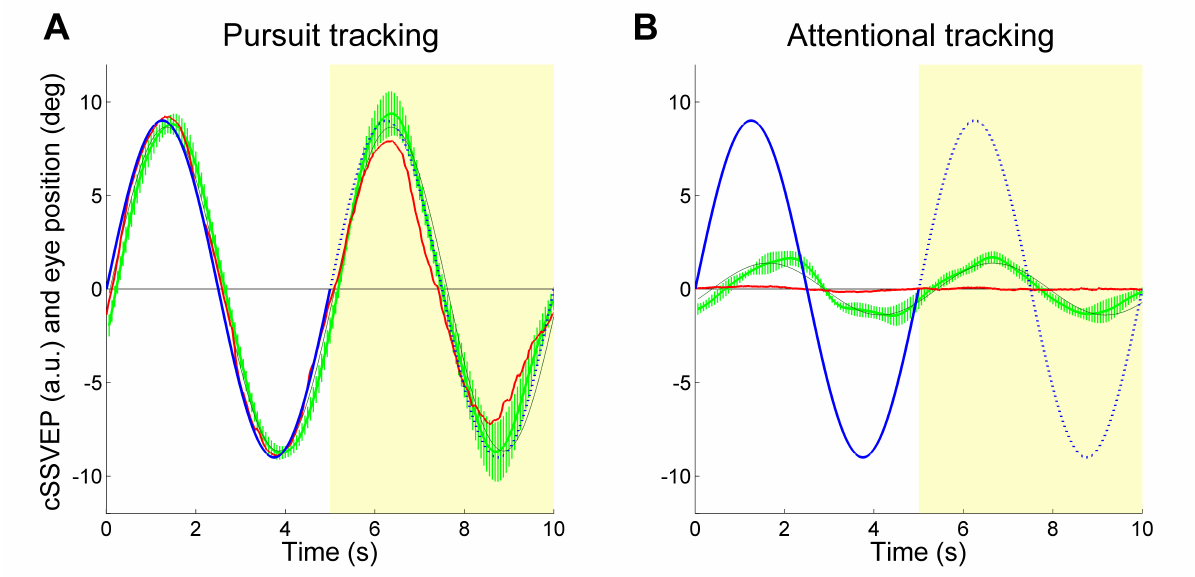
Figure 3: Average cSSVEP modulation (green traces) during vertical sinusoidal tracking in the 2 tasks. Only the second (perception) and third (imagery) tracking cycles are illustrated. The thickness of the trace represents the instantaneous 99% confidence interval around the mean. The thin dark sinusoidal curves superimposed on the cSSVEP traces are the best fitting curves for the perception and imagery cycles. Target position and average eye position are shown in blue and red, respectively. The yellow transparent patch indicates the imagery